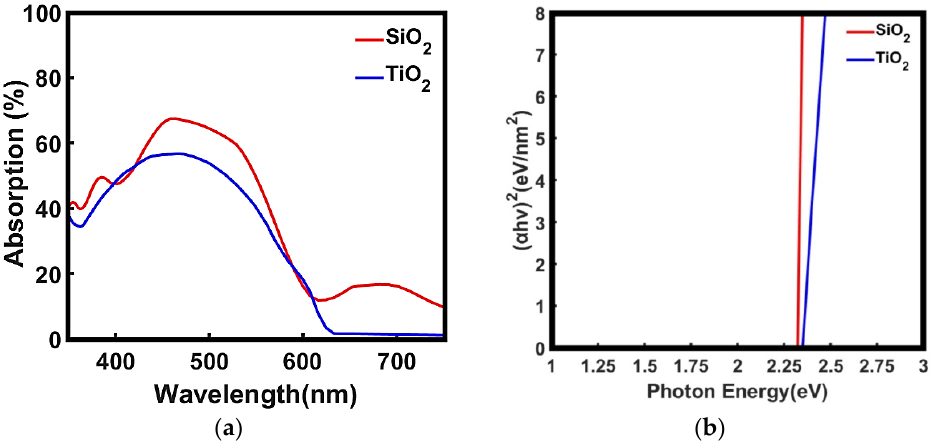
Figure 2. ( a ) UV-Vis absorption spectrum of photoanodes based on TiO 2 and SiO 2 ; ( b ) Tauc curve for photoanodes based on TiO 2 and SiO 2 .